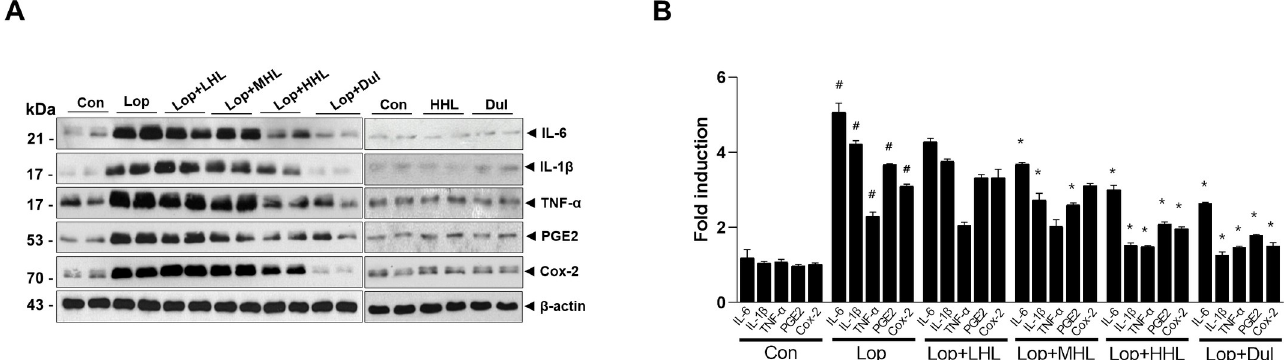
Fig 3. Effects of HLp-nF1 on inflammation state in loperamide-induced constipation. Eight-week-old rats were treated with loperamide along with 3.2 × 10 10 , 8 × 10 10 , and 1.6 × 10 11 cells/mL HLp-nF1, and Dulcolax, individually. A single treatment with 1.6 × 10 11 cells/mL HLp-nF1 or Dulcolax was used as the control. ( A ) Immunoblotting for anti-IL-6, IL-1 β , TNF- α , PGE2, COX-2, and β -actin antibody was performed using the ileum samples. ( B ) The expression of these proteins were quantified. A t-test was used to determine the means of two groups (n = 4) . � P < 0.05 vs. control group, # P < 0.05 vs. loperamide-treated group. Con , control group; Lop , loperamide-treated group; Dul , Dulcolax-treated group (0.75 mg/kg); HHL , treatment with 1.6 × 10 11 cells/mL HLp-nF1; Lop+LHL , treatment with loperamide and 3.2 × 10 10 cells/mL HLp-nF1; Lop+MHL , treatment with loperamide and 8 × 10 10 cells/mL HLp-nF1; Lop+HHL , treatment with loperamide and 1.6 × 10 11 cells/mL HLp-nF1; Lop+Dul treated group.